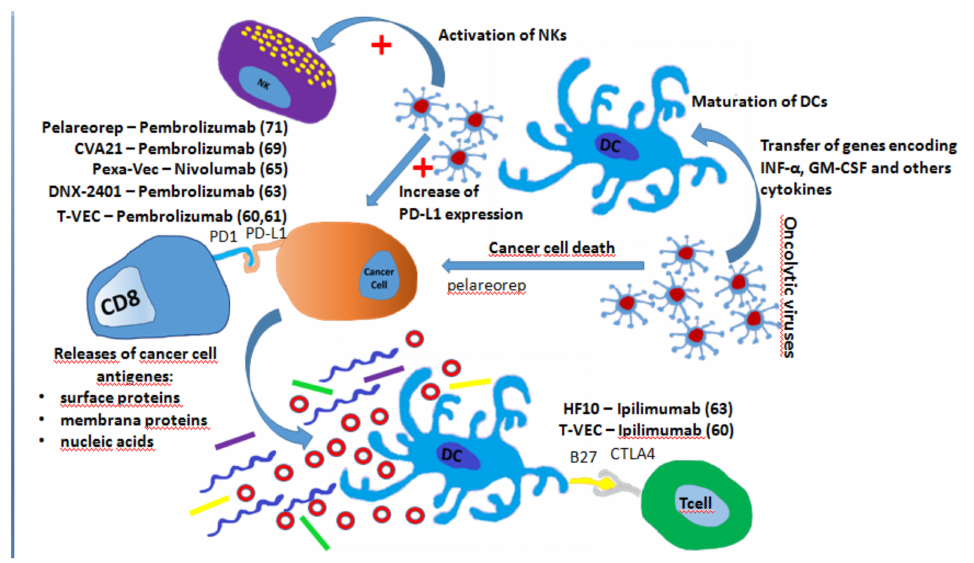
Figure 3. Summary of the mechanisms involved in improving of ICI e ffi cacy by oncolytic viruses: Release of damage-associated molecular patterns after tumor cell lysis, transfer of genes encoding INF- α , GM-CSF and others cytokines, DC maturation and activation, natural killer (NK) cell activation, and increase in PD-L1 expression. The main studies evaluating the combination of oncolytic viruses are also